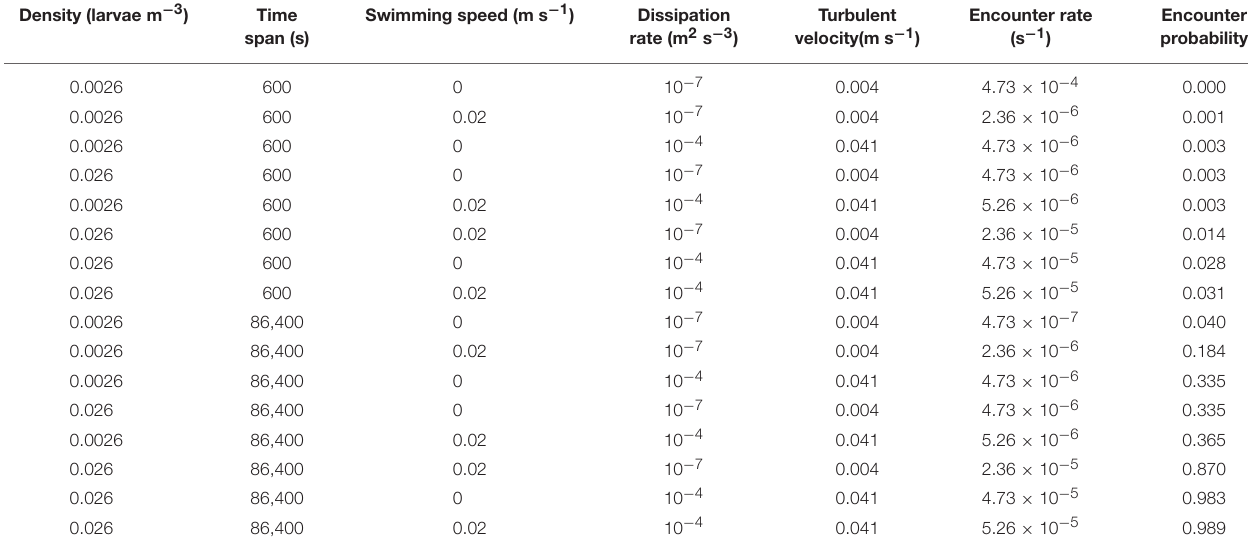
TABLE 2 | Sensitivity analysis of larval encounter rates and probabilities as a function of larval density, time span, larval swimming speeds, and turbulent velocities.